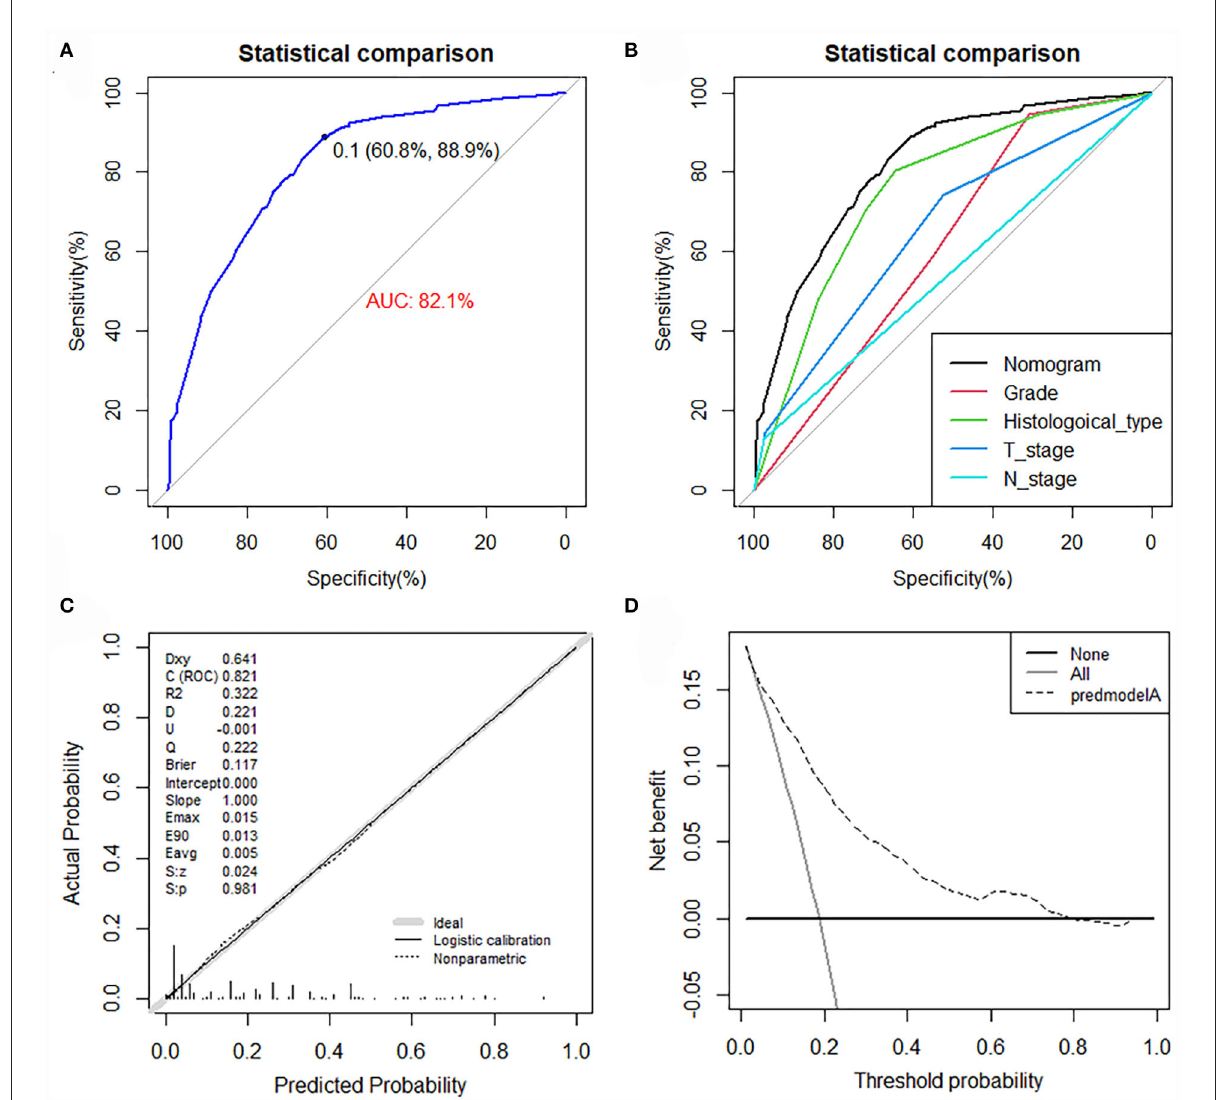
FIGURE5 ROC curve (A) , comparison of AUC between the nomogram and all predictors (B) , calibration curve (C) , and DCA curve (D) of the expanded validation